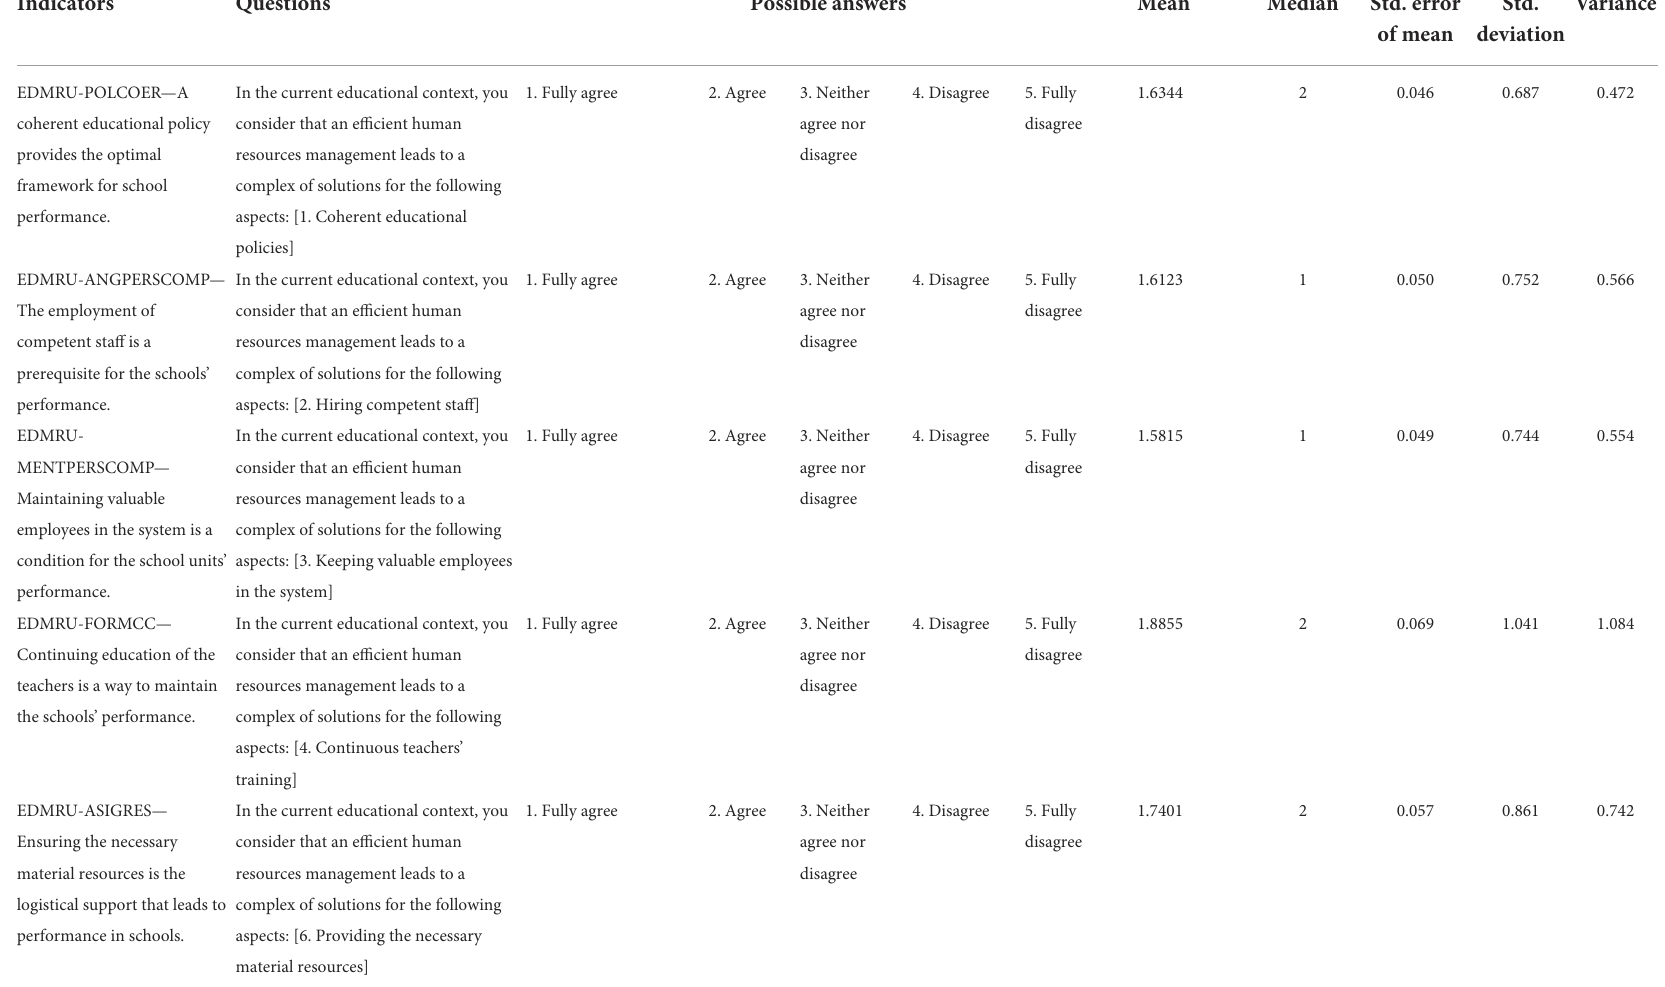
TABLE 1 Descriptive statistics of the variables subject to modeling.